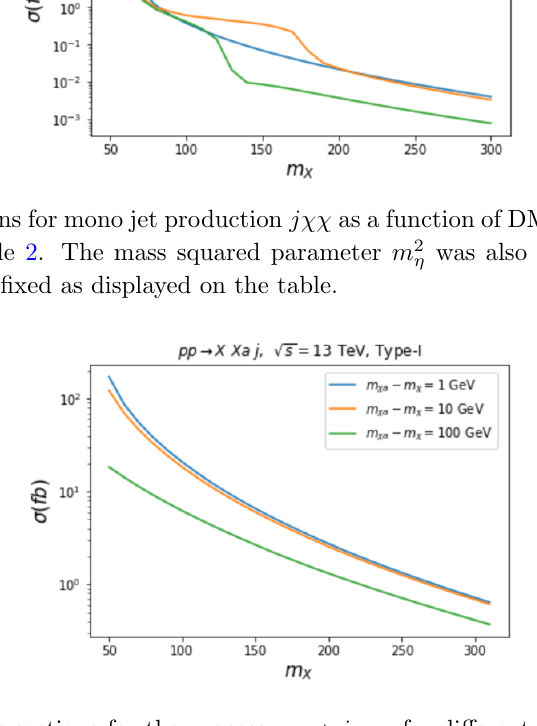
Figure 6 . Cross sections for the process pp ! j(cid:31)(cid:31) a for di(cid:11)erent mass